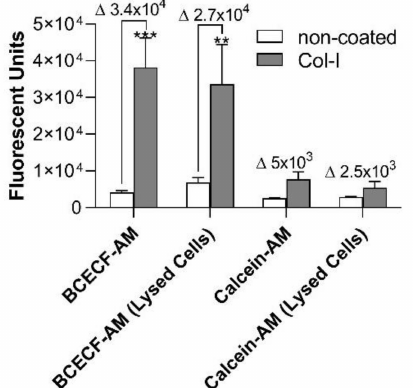
Figure 4. Platelet adhesion detection using di ff erent techniques: BCECF-AM vs. Calcein-AM. Coating of 96-well microplates with collagen-I (4 µ g / mL in 50 µ L) or distillated water were performed for 1 h at 37 ◦ C. After blocking the wells with BSA (0.03%), human washed platelets (8 × 10 4 / µ L in 100 µ L)